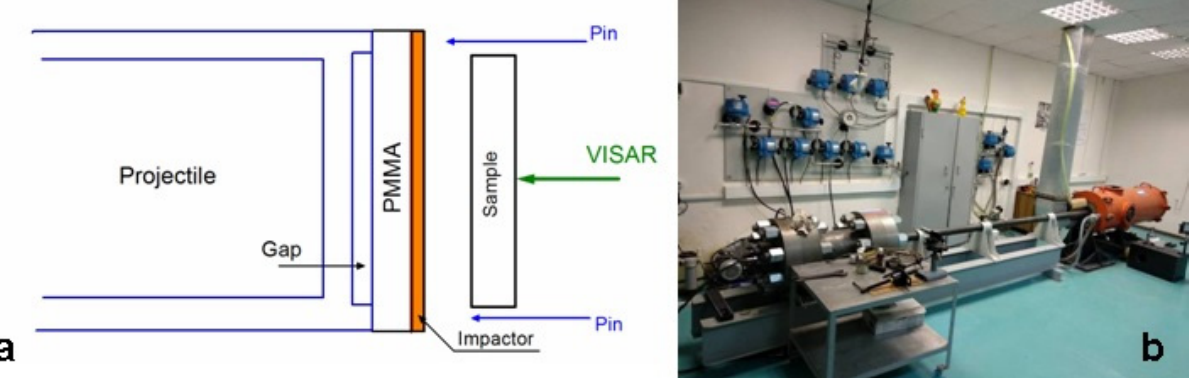
Figure 2. Scheme of shockwave experiments on loading of the Inconel 718 samples with a pneumatic gun ( a ), photo of an experimental pneumatic throwing system ( b ).